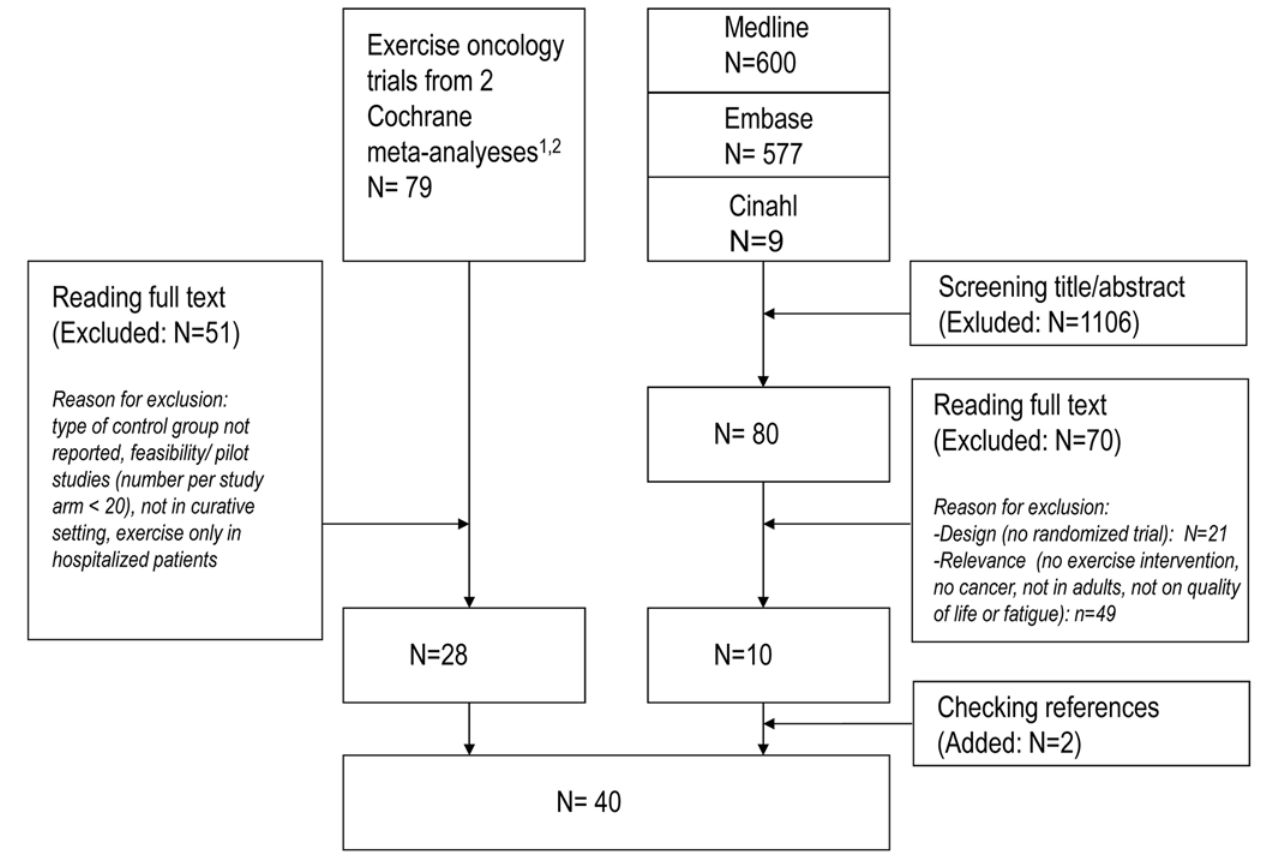
Fig 1. Flowchart of included studies. Exercise oncology trials of the literature search between 19-4-2012 and 16-8-2013 and from two Cochrane reviews updated on 19-4-2012 and 1-6-2012. [1,2].